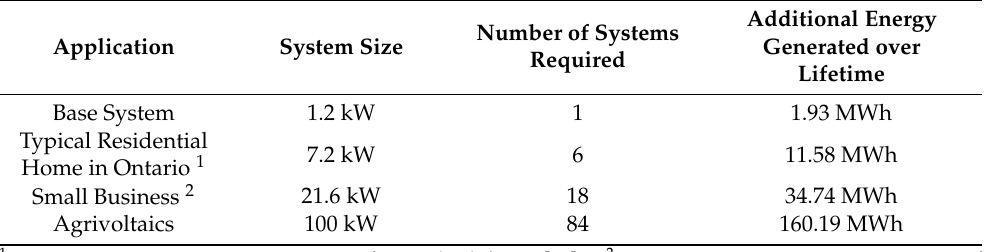
Table 10. The additional energy generated over the lifetime of a system for scaled up applications, assuming monthly tilt adjustments, capped at 60 ◦